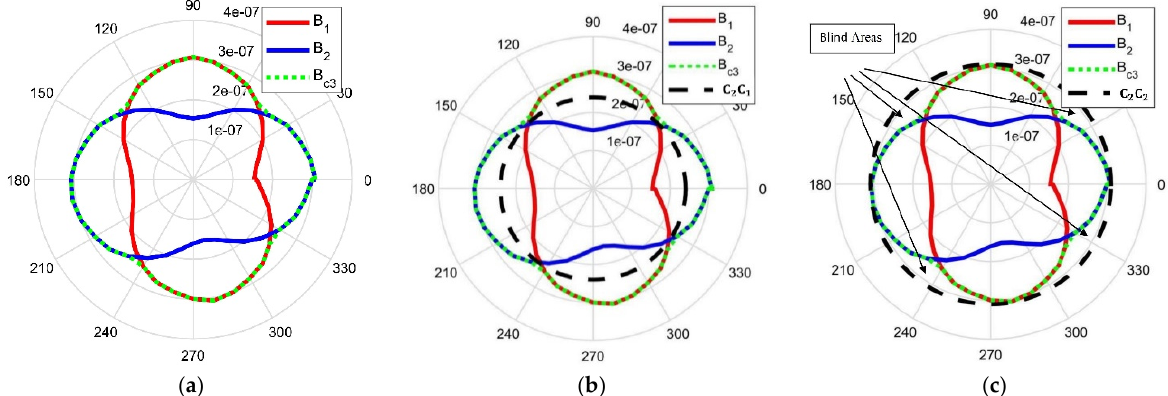
Figure 6. Max flux density of the magnetic fields and its directivity pattern calculated at xy plane, and keeping the z = 1 m, coil radius of transmitter Tx and receiver Rx = 0.104 m; turns of the coil are N = 28, current I = 1.62 × 10 − 7 , and frequency f = 125 KHZ. ( a ) Configuration 2. ( b ) Configuration 2 case 1. ( c ) Configuration 2 case